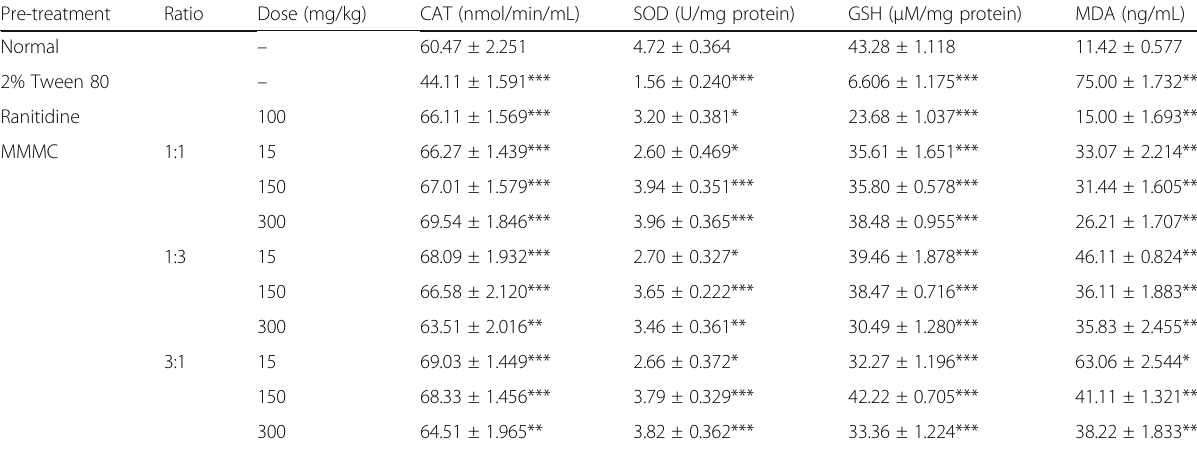
Table 3 Antioxidant activity of MMMC against ethanol-induced gastric ulcer in stomach tissue of rats Pre-treatment